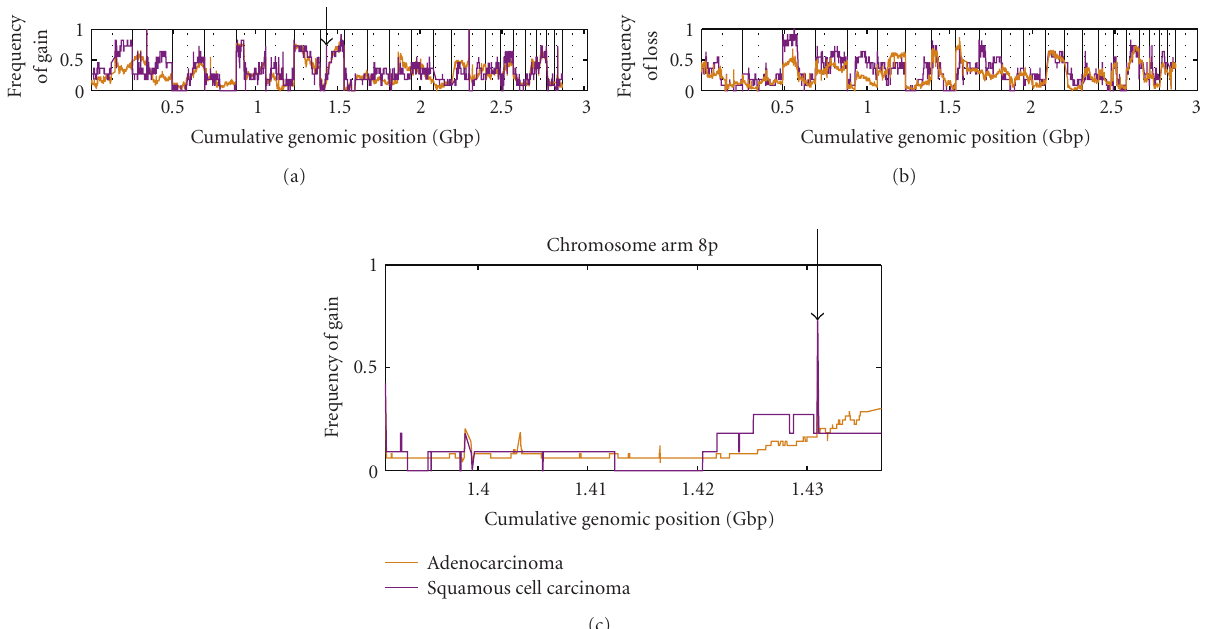
Figure 5: Genome-wide comparison of lung adenocarcinoma (AC) and squamous cell carcinoma (SqCC). A ff ymetrix SNP 6.0 data for 11 SqCC and 49 AC cell lines were downloaded from the Wellcome Trust Sanger Cancer Genome Project. Data were analyzed against a pool of a normal reference samples using Partek Genomics Suite. For each position in the genome, the frequency of (a) gain and (b) loss are shown for SqCC (purple) and AC (orange). (c) Magnified view of chromosome arm 8p shows that SqCC has a higher frequency of segmental DNA gain at cumulative position 1.43 Gbp as compared to